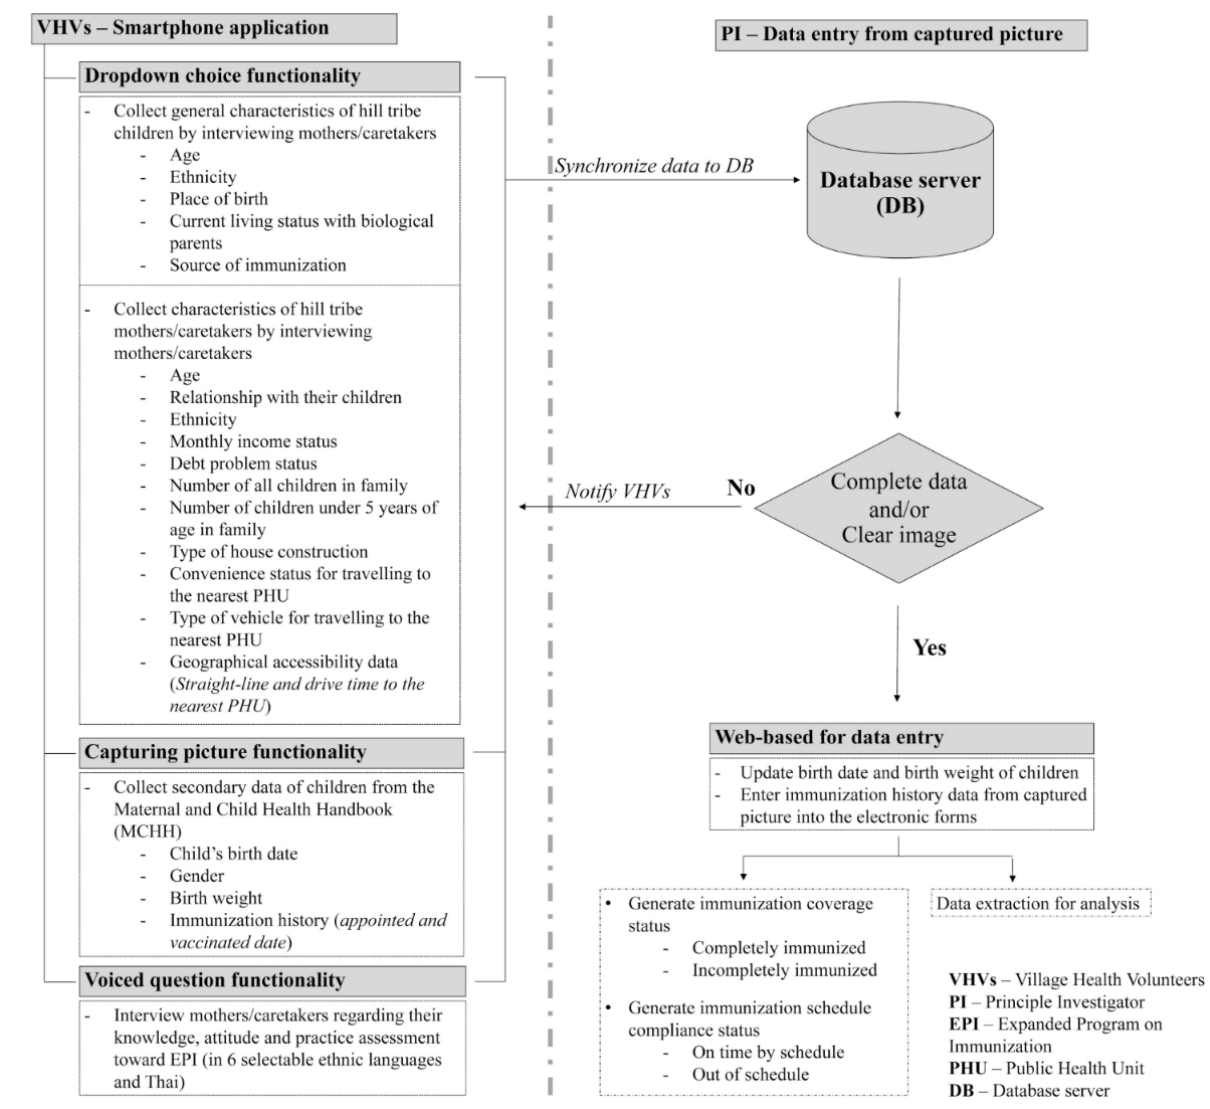
Figure 2. Concept and workflow of the smartphone